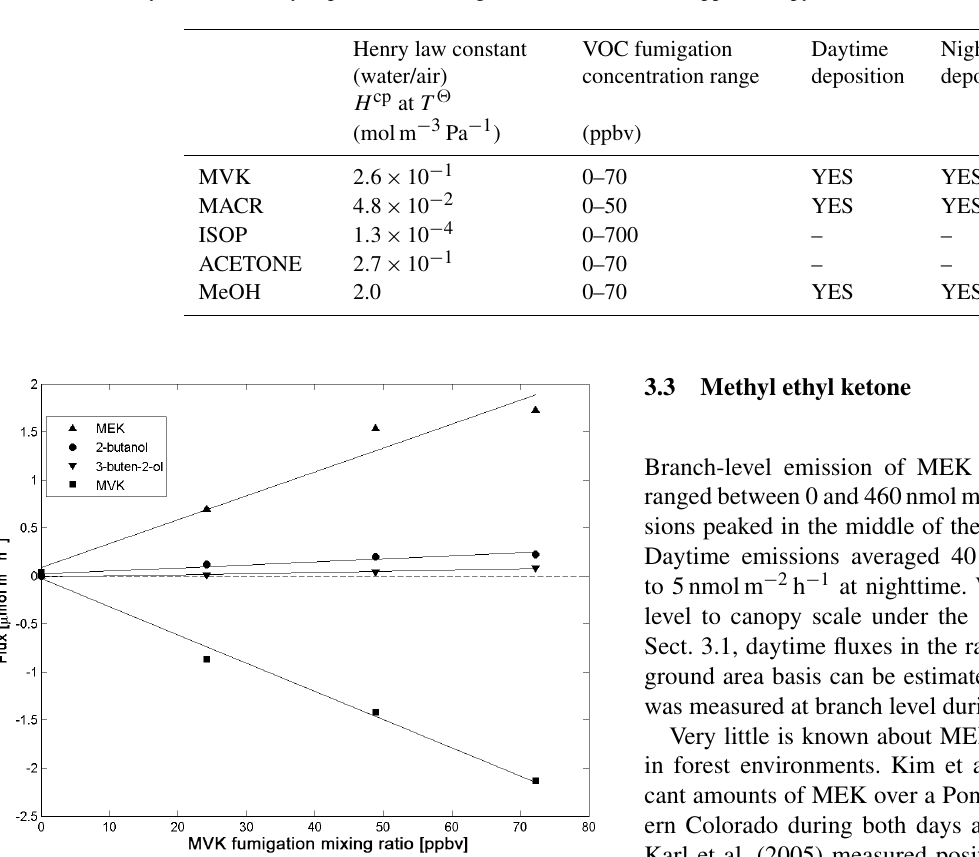
Figure 3. Example of branch-level VOC flux measured as a func- tion of MVK fumigation mixing ratio during daytime. The con- comitant MVK uptake and emission of MVK reduction prod- ucts (namely MEK, 3-buten-2-ol, and 2-butanol) implies plant detoxification of MVK. Linear fit parameters are the following: MEK ( R 2 = 0 . 954; y = 0 . 0249 x + 0 . 0869); 2-butanol ( R 2 = 0 . 928; y = 0 . 0031 x + 0 . 0226); 3-buten-2-ol ( R 2 = 0 . 956; y = 0 . 0102 x − 0 . 0102); MVK ( R 2 = 0 . 991; y = − 0 . 0293 x − 0 .